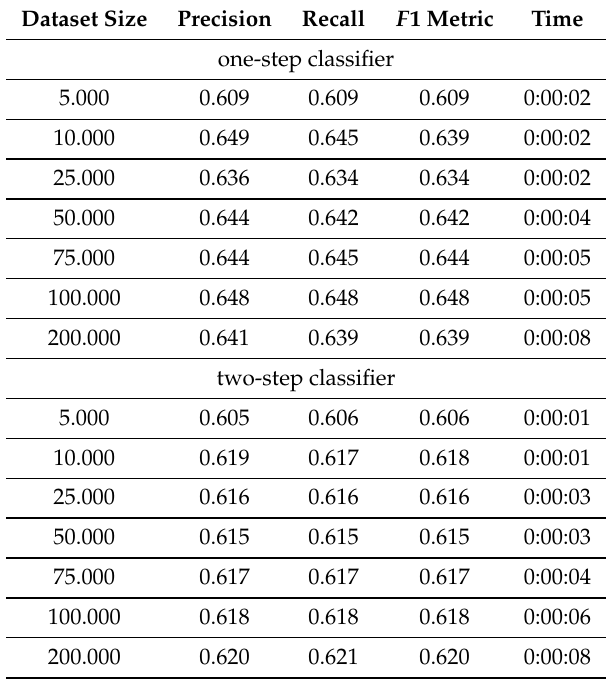
Table 3. Logistic